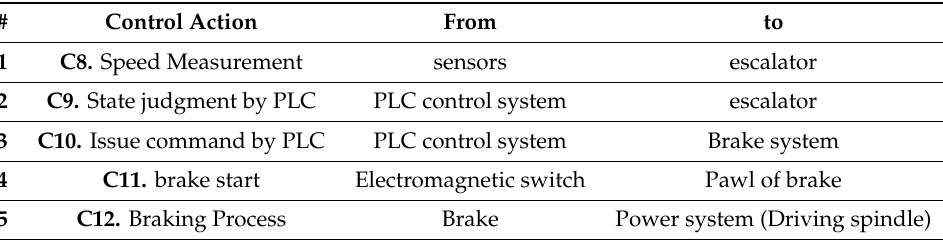
Table 4. Control process in Level 2.